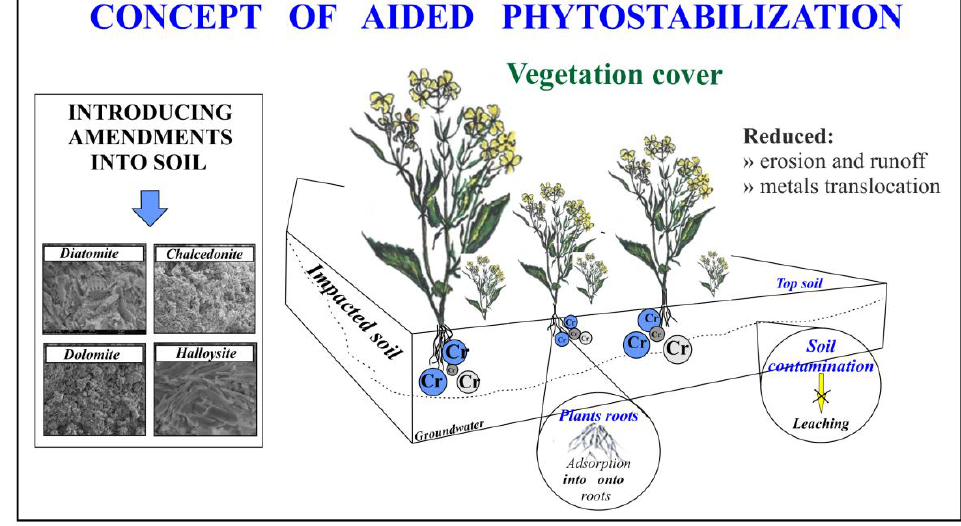
Figure 1. Concept of aided phytostabilization.